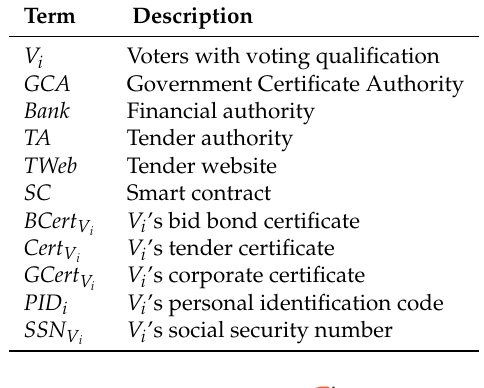
Table 4. Description of our E-bidding system.